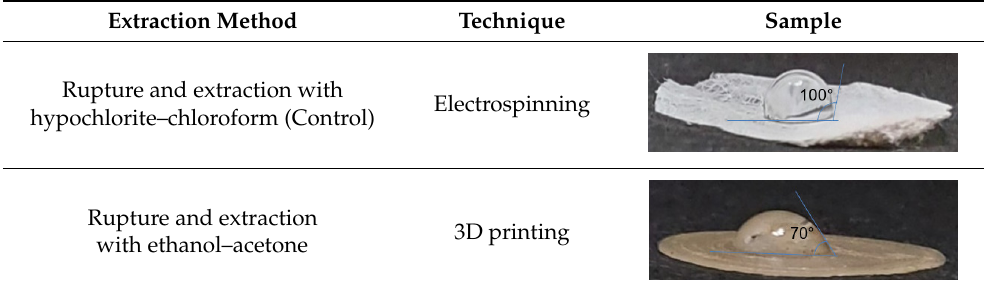
Figure 3. Morphological of the generated scaffolds, ( A ) the conventional method (Control), ( B ) the ethanol–acetone.